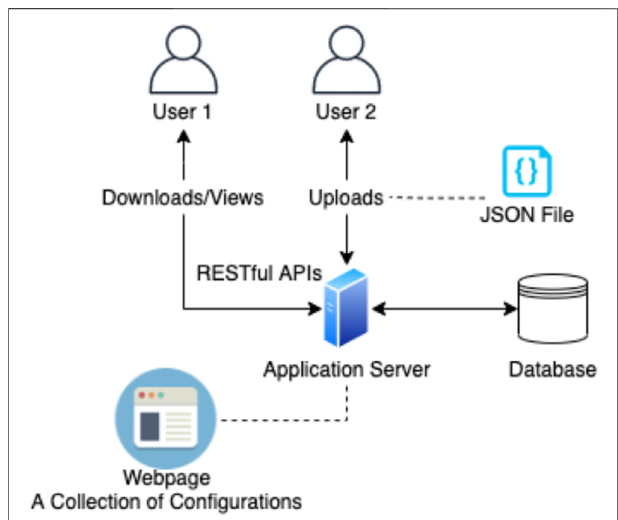
FIGURE 6 | The shared model of con fi gurations (JSON fi le) in the